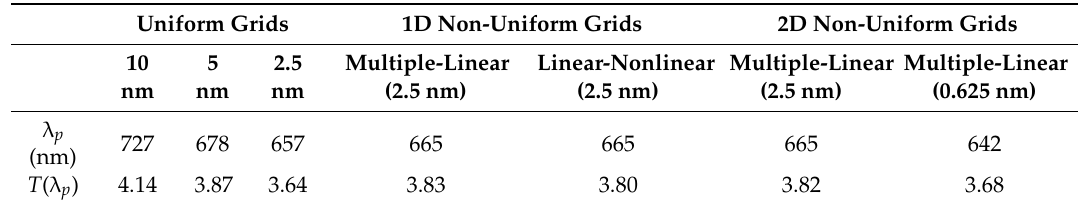
Figure 4. Normalized transmittance spectrums from: the cases of uniform grids when Δ = 10 nm (green curve), 5 nm (cyan curve), and 2.5 nm (blue curve), respectively, the converged profile (purple curve) from the linear curve fitting (see text), theoretical prediction (black curve) from [33], the cases of 1D non-uniform grids with Δ x 1 = 2.5 nm when the mapping functions are multiple-linear (long dashed brown curve) and linear-nonlinear (long and short dashed golden curve), respectively, and the cases of 2D non-uniform grids with Δ x 1 = Δ z 1 = 2.5 nm (dashed red curve) and 0.625 nm ( long dashed black curve), respectively, when both of the mapping functions are multiple-linear. Table 1. Wavelength at peak transmittance λ p and corresponding peak T ( λ p ) for the cases of uniform grids, 1D non-uniform grids, and 2D non-uniform grids.